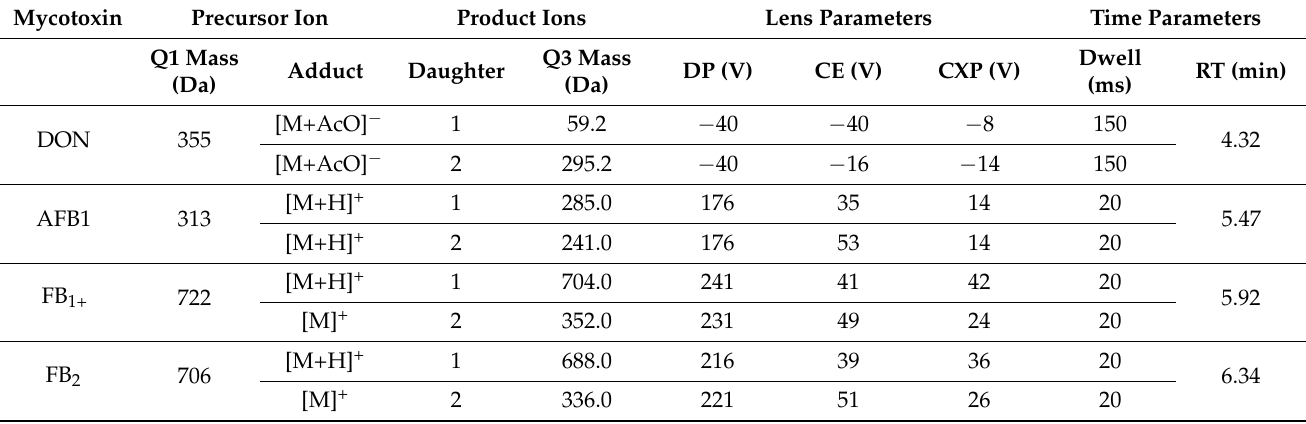
Table 2. Optimized parameters of measured mycotoxins: deoxynivalenol (DON), aflatoxin B1 (AFB1), and fumonisin FB 1 +FB 2 ). Lens parameters: collision cell exit potential (CXP), declustering potential (DP), and collision energy